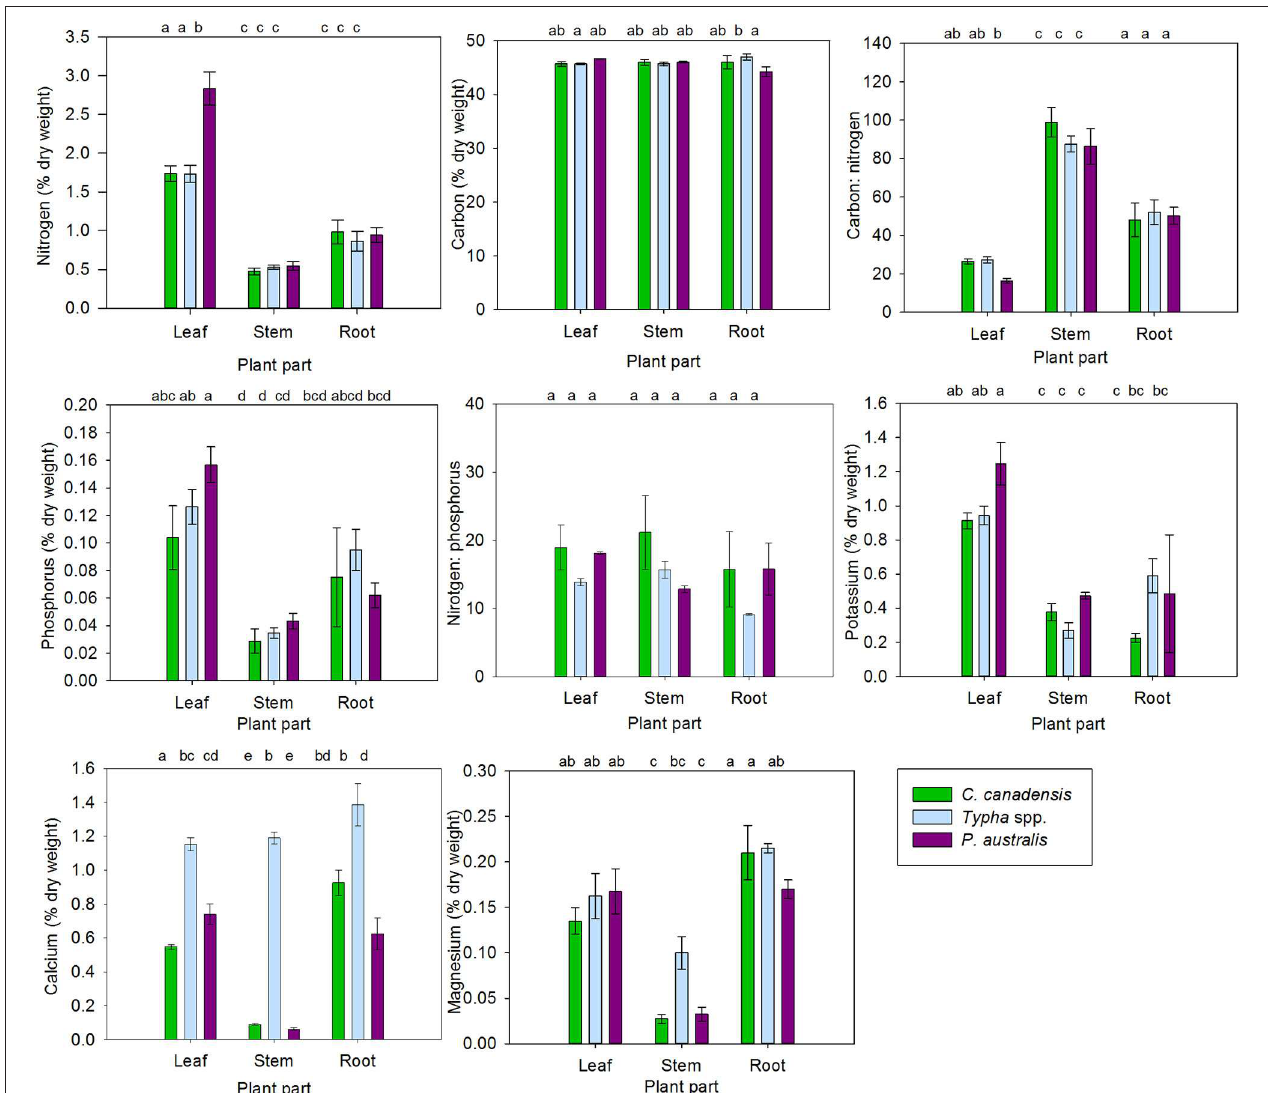
FIGURE 4 | Carbon and nutrients (% dry-weight) in C. canadensis , Typha spp., and P. australis leaves, stems, and belowground tissues (called “Root” in plots for simplicity). Samples collected from meadow ( n = 5/wetland), cattail ( n = 5/wetland) and P. australis -invaded marsh ( n = 5/wetland) in the Big Creek National Wildlife Area ( n = 15) and the Long Point Provincial Park ( n = 15) in August 2016. Note that this averages tissues from a relatively high nutrient environment (Big Creek) with tissues from a relatively low nutrient environment (Long Point). Error bars represent standard error. Letters above bars indicate significant differences in nutrient content between plant species and tissue type at p < 0.05 ( Supplementary Materials 2